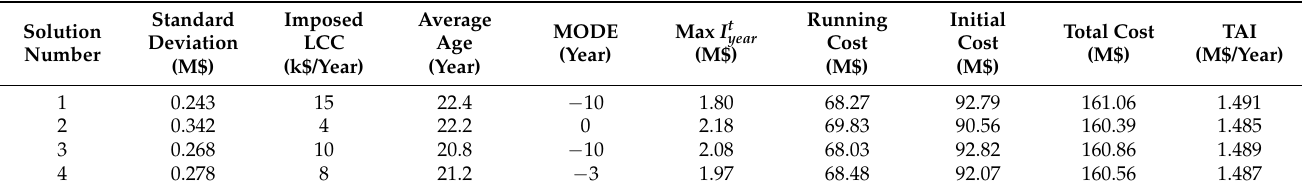
Table 5. Details of four selected points for Scenario 2 (replacement time boundary = ± 10 years, annual budget limit = 2.2 M$). Solution